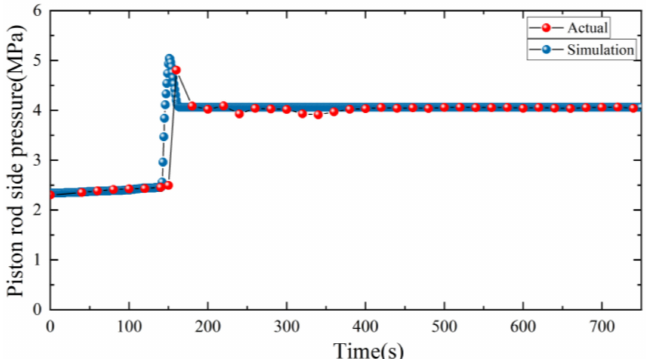
Figure 15. Piston rod side pressure when lowering.